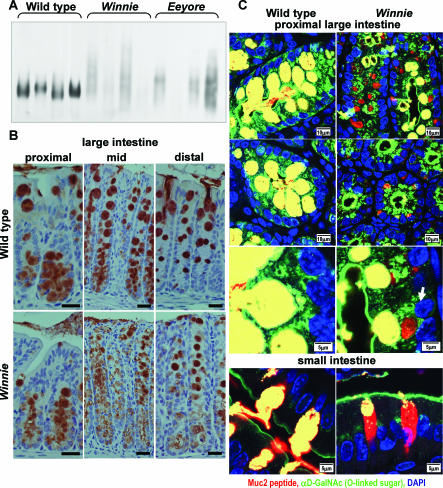
Altered Muc2 Protein Expression in Mice with Muc2 Mutations(A) Muc2 proteins from wild-type, Winnie, and Eeyore intestinal extracts were reduced and separated by agarose gel electrophoresis and detected by Western blotting with the mM2.2 antibody. Note the reduced intensity and the altered electrophoretic migration in the mutant proteins.(B) Cellular localization of Muc2 in wild-type and Winnie colon tissue determined by immunohistochemistry with affinity purified mM2.2 antibody. Note the decreased size of goblet cell thecae and cytoplasmic Muc2 staining outside thecae in Winnie; scale bars = 25 μm.(C) Confocal microscopy of wild-type and Winnie goblet cells from the proximal colon and small intestine showing vacuolar accumulation of Muc2 (red) lacking O-linked sugars identified with the DBA lectin (green) in Winnie only. Goblet cell thecae appear yellow due to merging of the red Muc2 core peptide with the green O-linked sugar. Nuclei are stained with DAPI (blue). Scale bars as marked. Single colour images of these composites are provided in Figure S5A–S5C.